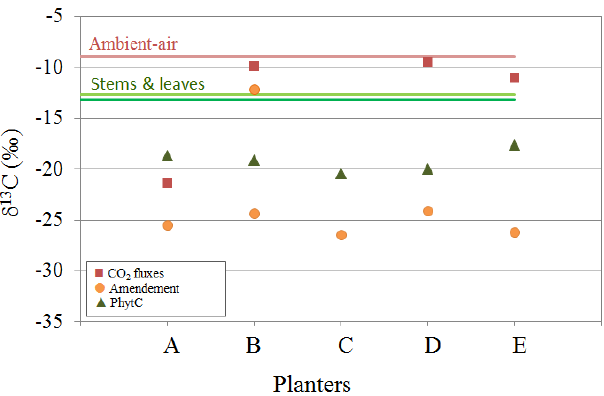
Figure 5. Below-ground C manipulation experiment. δ 13 C values of the respired CO 2 , stems and leaves, amendments and phytC for the five planters enriched in organic carbon nutrients (A–E). Values are reported as per mil (‰) related to PDB, and individual symbols represent single results as reported in Table S3. For Planter B we report two values, its OC fraction ( − 24.3‰) and its bulk fraction ( − 12.1‰ – a mixture of OC and inorganic carbon) (Table 1). Con- stant solid lines correspond to the average δ 13 C values of ambient- air CO 2 and bulk plant tissues.